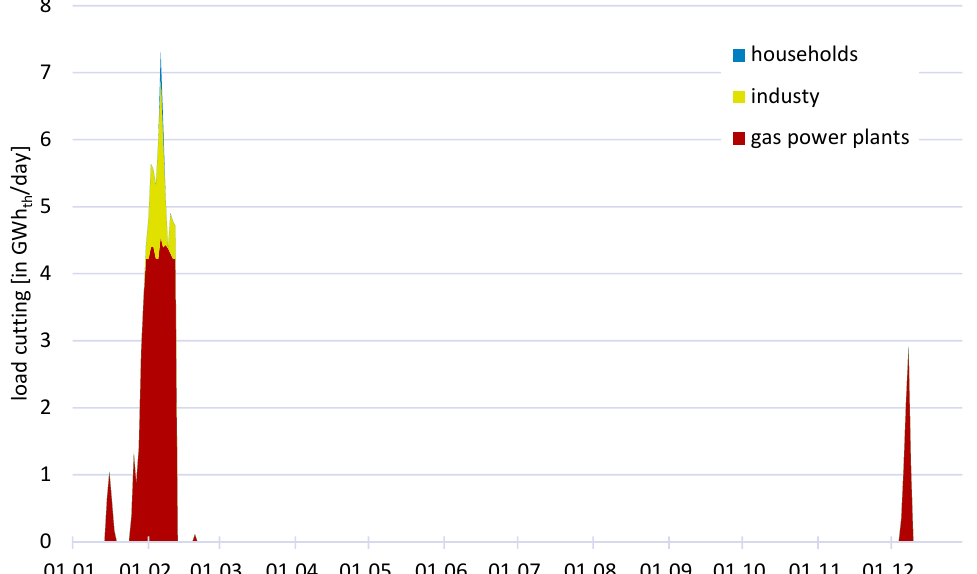
Figure 9. Results of GAMAMOD-DE for load shedding in Germany in daily resolution for 2012 aggregated by sector.